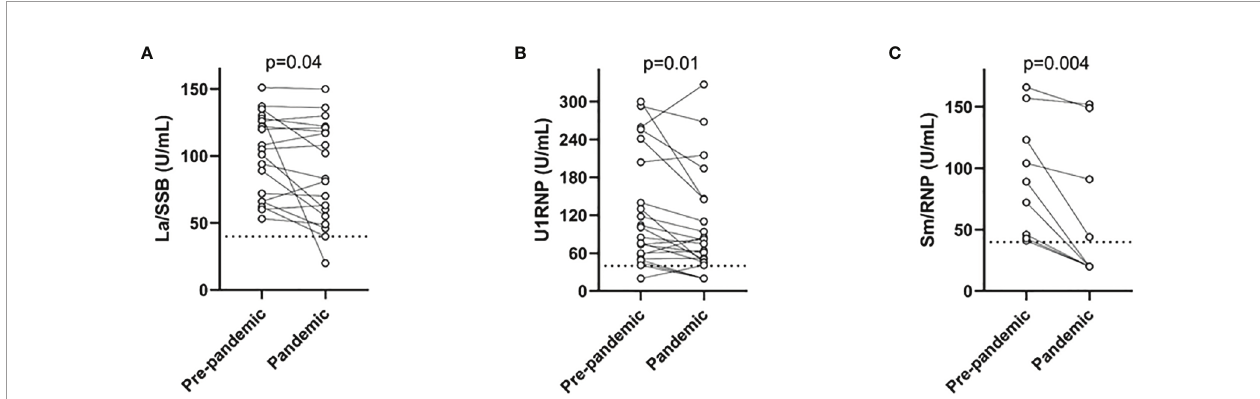
FIGURE 3 | Levels of three antinuclear antibodies (ANA) targeting extrachromosomal antigens demonstrated before and during the pandemic. Signi fi cantly lower levels of La/SSB (A) , U1RNP (B) , and Sm/RNP (C) were found during the pandemic compared with prepandemic samples. To increase the readability, only patients with at least one sample above the cutoff of the assay (before or during the pandemic) are shown.